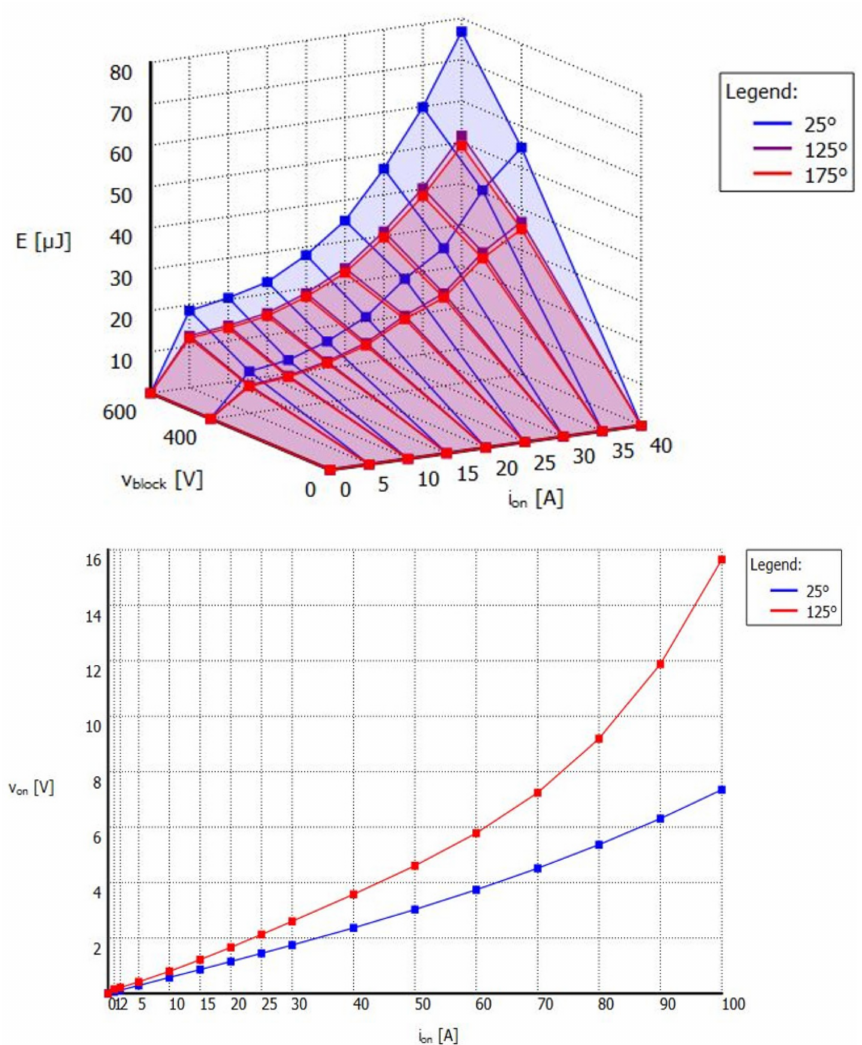
Figure 7. Turn-on energy, turn-off energy, and conduction loss variation (from top to bottom ,